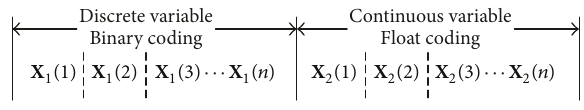
Figure 2: Individual bit string structure of parameter cascade